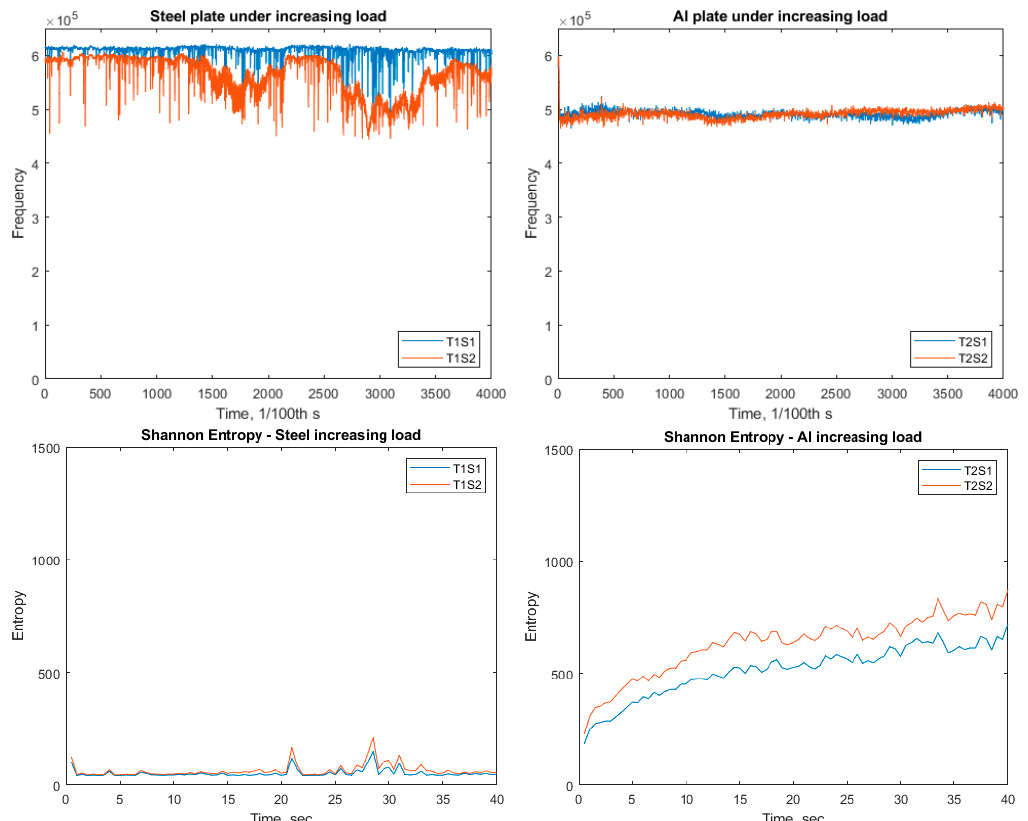
Figure 11. Centroid frequency ( top ) and Shannon entropy ( bottom ) for the increasing load tests after a 300 kHz high pass filter has been applied to the signal.